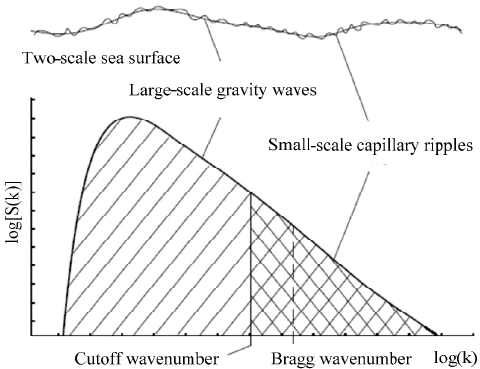
Figure 2. Sea wave spectrum S ( k ) versus the wavenumber.